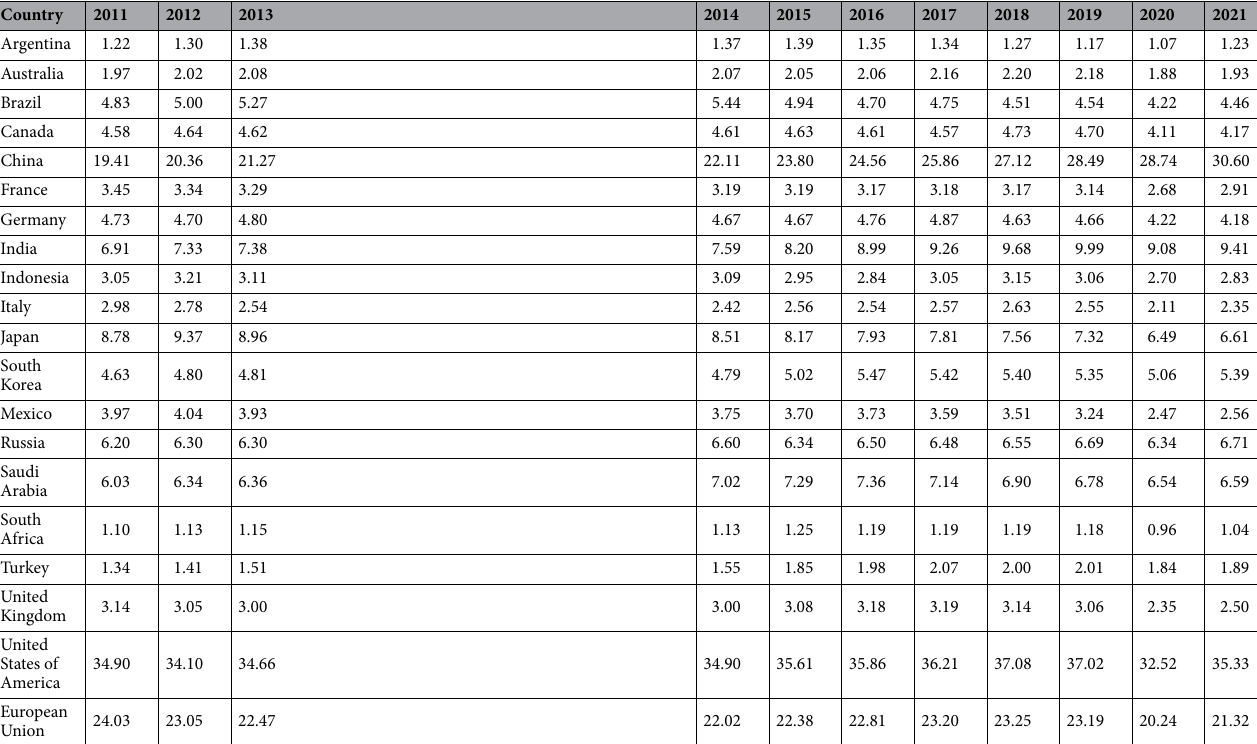
Table 5. Oil consumption data of G20 countries 47 . All consumption in